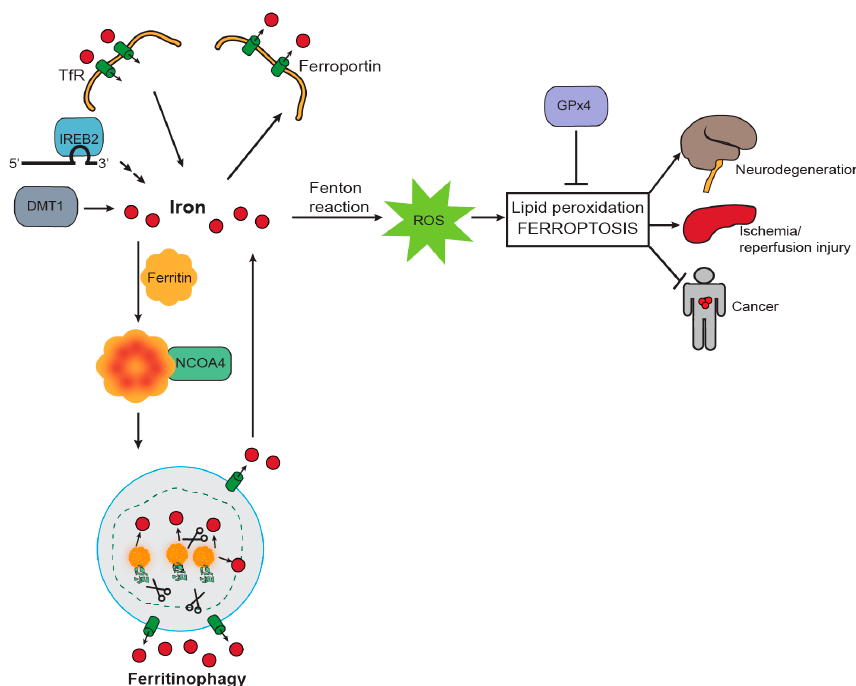
Figure 2. Iron and ferritinophagy are required for ferroptosis induction. Iron release in the cytosol can generate Reactive Oxygen Species (ROS) by the Fenton Reaction. ROS leads to lipid peroxidation and ferroptosis. Iron increase in the cytosol is mediated by increased import (by the transferrin receptor: TfR), decreased export (by ferroportin), increased translation of iron-metabolism related mRNAs via Iron Response Element Binding Protein 2 (IREB2) and increased cytosolic flux by Divalent Metal Transporter 1 (DMT1). Iron can also be stored in ferritin and delivered to the lysosome for NCOA4-mediated iron release from the lysosome. Increased ferritinophagy flux contributes to ferroptosis. Glutathione Peroxidase 4 (GPx4) repairs lipid peroxidation and inhibits ferroptosis. Ferroptosis is a promising therapeutic target. Inhibiting ferroptosis could protect from iron-induced cell death in neurodegeneration and ischemia/reperfusion injury while triggering ferroptosis could be effective in cancer